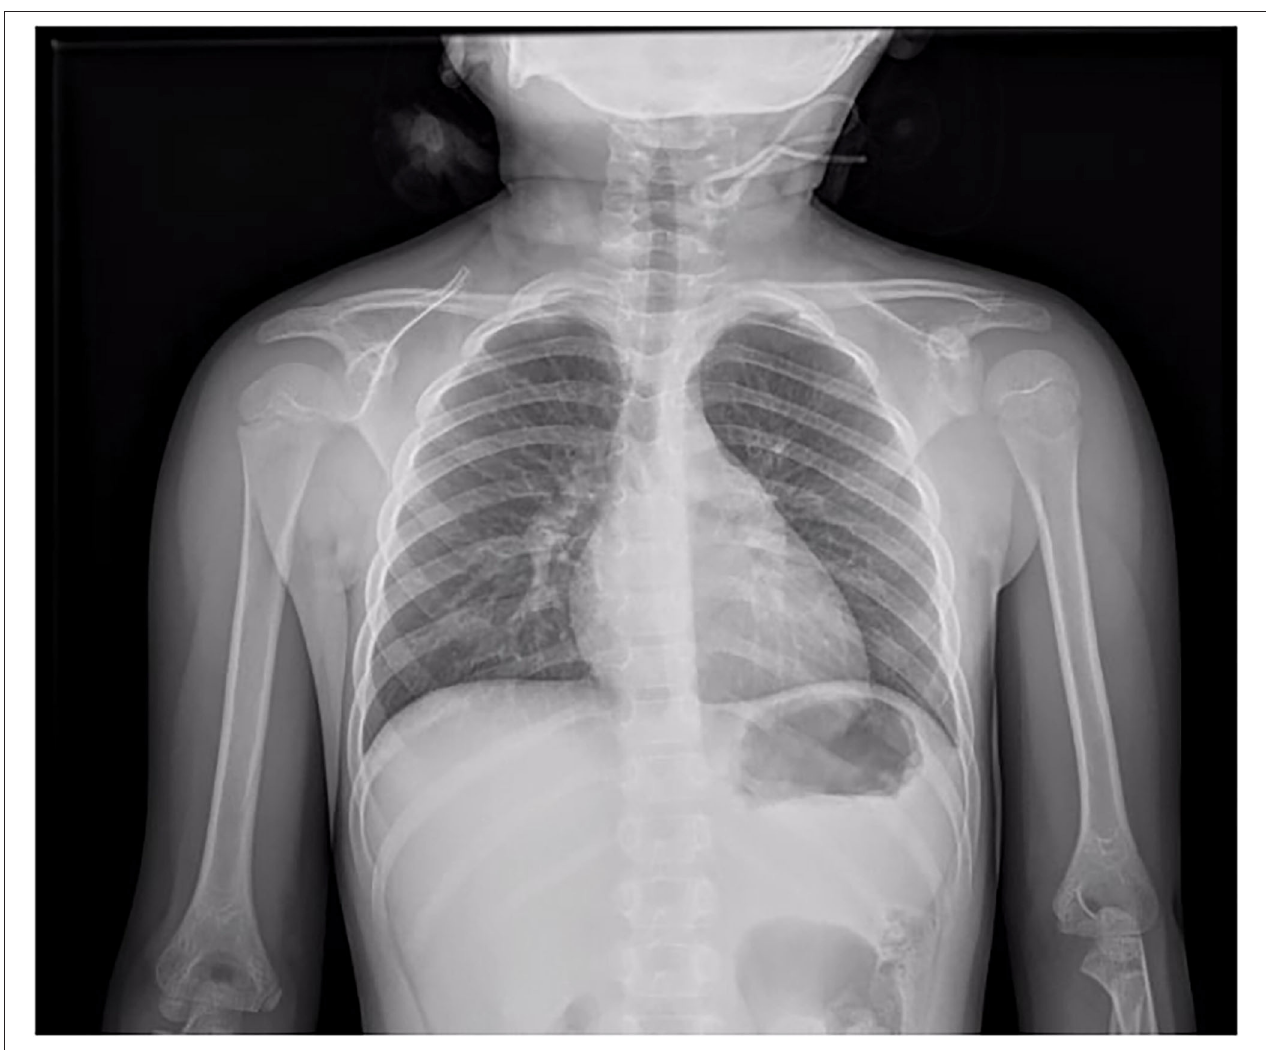
FIGURE 1 | Chest x-ray showed slight thickening of the interstitial web with mild bilateral pleural